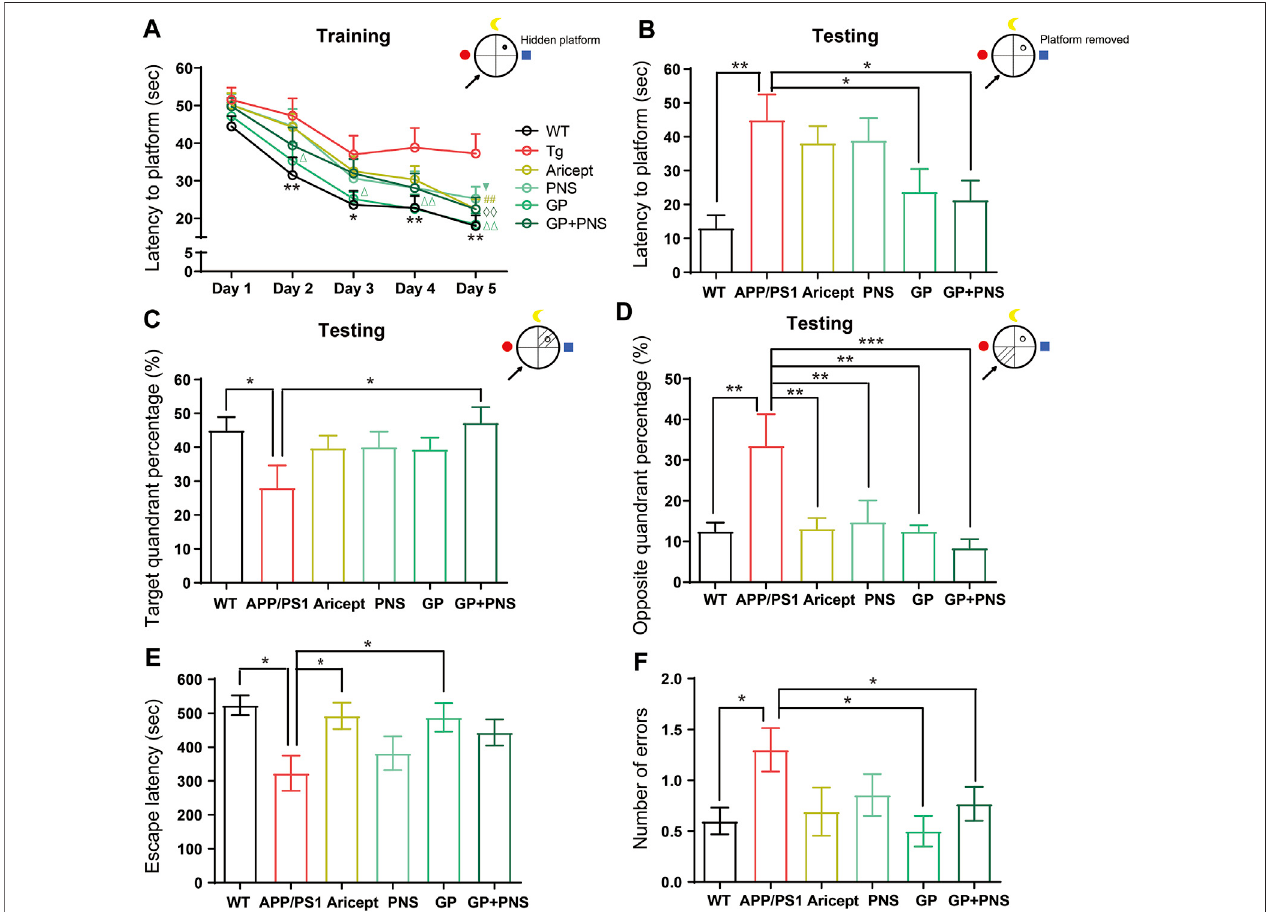
FIGURE4| Learningandmemoryperformanceenhancement. (A) Inthetrainingtrial ofMWM,thelatency toplatform. (B) Inthetesting trialofMWM,thelatency to platform. (C,D) Inthetesting trialofMWM,thepercentage oftargetquadrant (C) and oppositequadrant (D) . (E,F) Intheavoidancetest, theescapelatency fromelectric shock (E) and the error number to the electric shock area (F) . ( n = 12, Data are means ± SEM. Compared between WT and APP/PS1, ** p < 0.01 and * p < 0.05, compared between NP and APP/PS1, ◊◊ p < 0.01; compared between GP and APP/PS1, ΔΔ p < 0.01 and Δ p < 0.05; compared with PNS and APP/PS1, ▼ p < 0.05; compared between Aricept and APP/PS1, ## p < 0.01 (two-way ANOVA for (A) . One-way ANOVA for others, compared with APP/PS1, *** p < 0.001, ** p < 0.01, and * p <